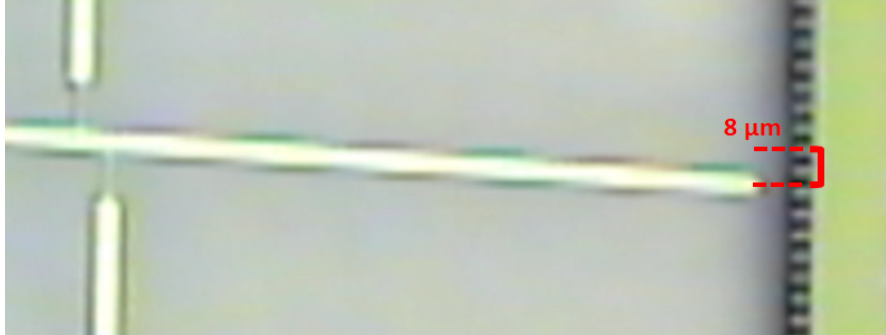
Figure 13. Shift of strain gauge indicating bar (sample P2) after release from the substrate.